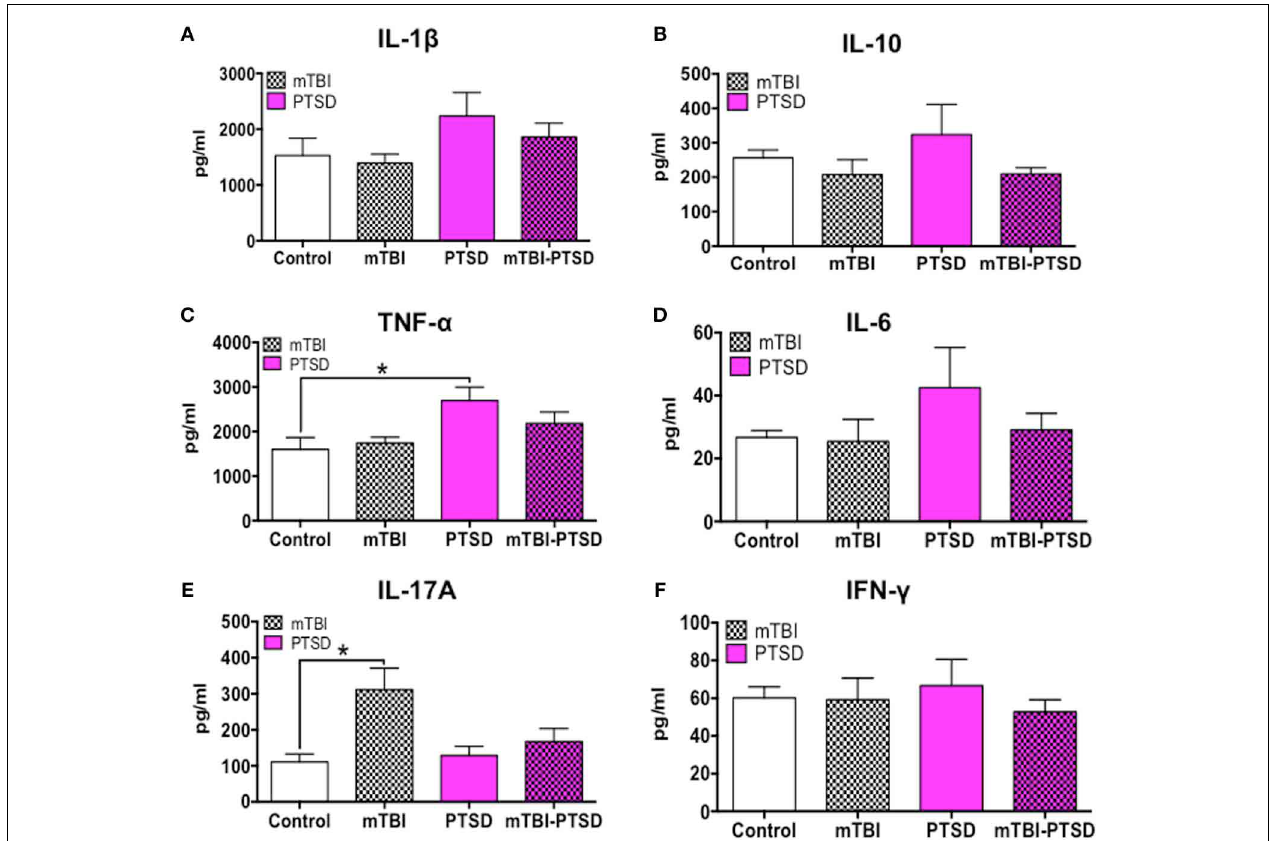
FIGURE 6 | Immune/inflammatory systemic response at acute time-point post-mTBI-PTSD. Levels of 6 different cytokines (IL-1 β , IL-10, TNF α , IL-6, IL-17A, IFN γ ) were measured in the plasma to detect systemic immune/inflammatory responses to mTBI and/or PTSD. There was an obvious trend toward increase in IL-1B, IL-10, TNF α , and IL-6 in PTSD only animals compared to control and mTBI groups, however this was only statistically significant with TNF α ( P = 0.036) and a marginal